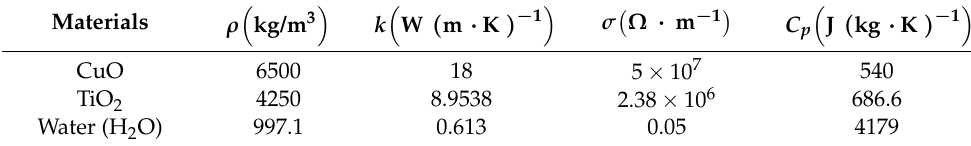
Table 2. Thermal and physical properties of the nanoparticles and the base fluid [36,37]. Materials